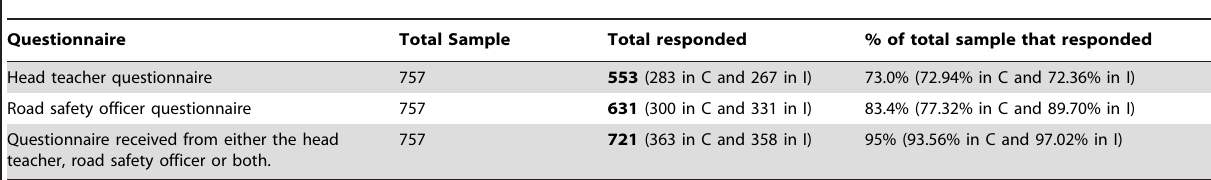
Table 2. Response numbers and rates from head teachers and road safety officers to the postal questionnaires.